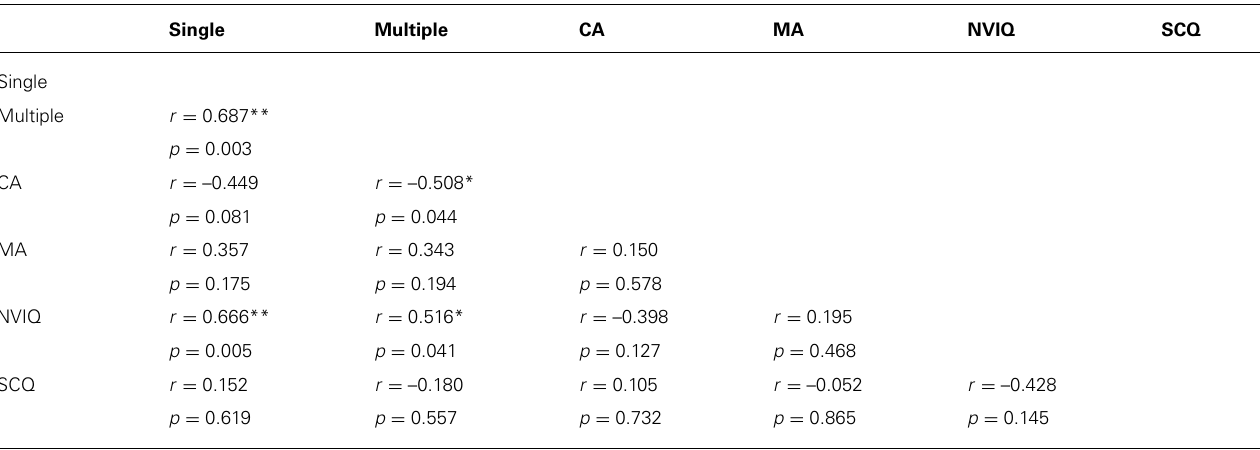
Table 2 | Correlations between symbolic understanding in the MappingTest of Single and Multiple trial types, and CA, MA, NVIQ, and autism severity